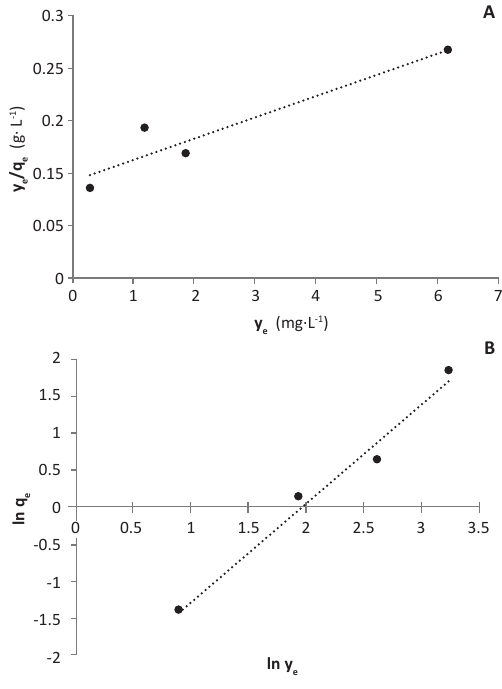
figURe 8. Langmuir (A) and Freundlich (B) isotherms of MB adsorption onto poplar sawdust at 298.15 K.